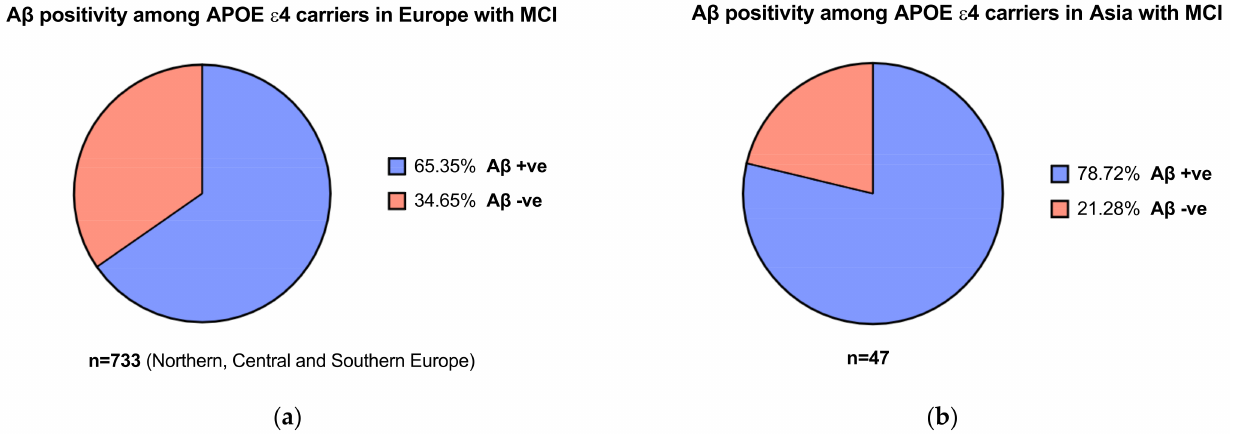
Figure 3. ( a ) A β positivity among APOE ε 4 carriers with mild cognitive impairment (MCI) in Europe ( b ) and in Asia. Data obtained from Mattson et al. [57].